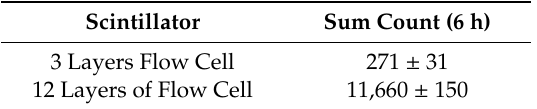
Table 14. Sum count comparison with the scintillation detectors of different layers.